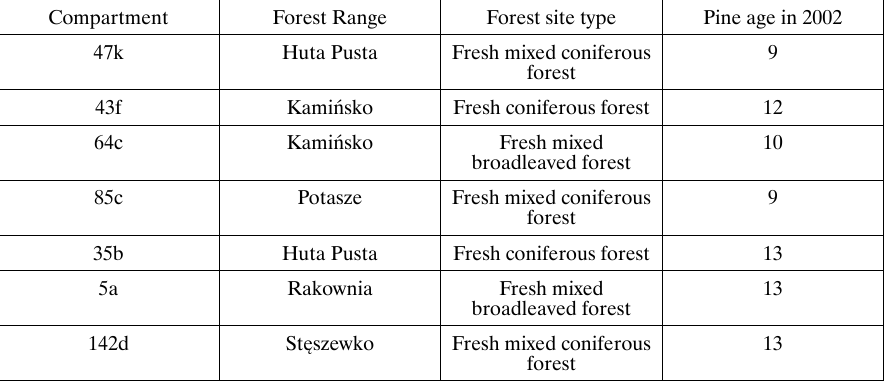
Characteristic and location investigation